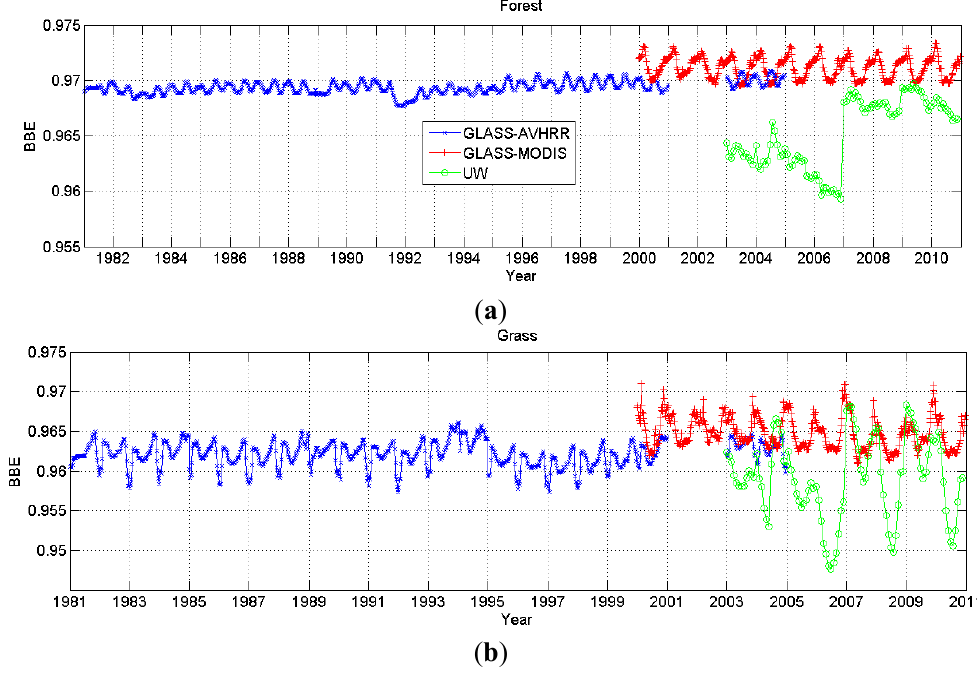
Figure 11. Long-term global BBE of five land cover types from GLASS BBE and UWIREMIS BBE product. ( a ) Forest; ( b ) Grass; ( c ) Crop; ( d ) Savanna; ( e )